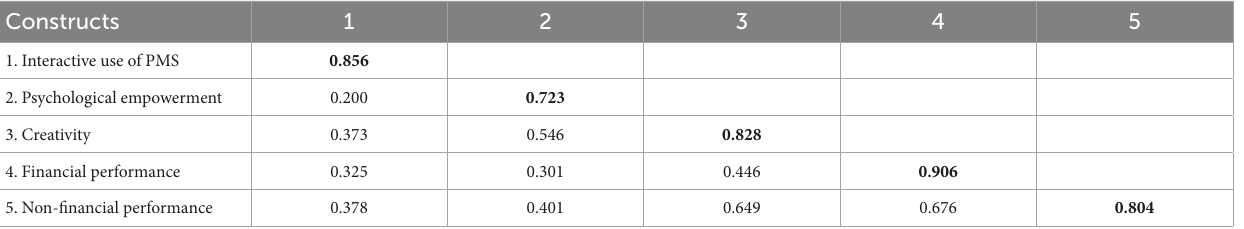
TABLE 4 Discriminant validity (Fornell-Larcker criterion).